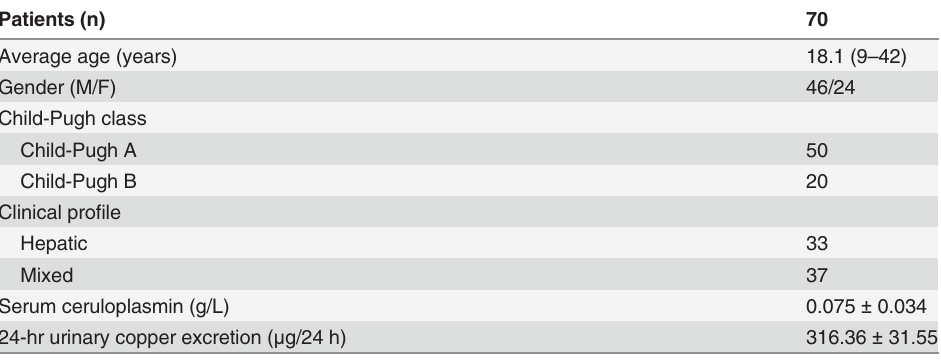
Table 1. Demographic and clinical features of the WD